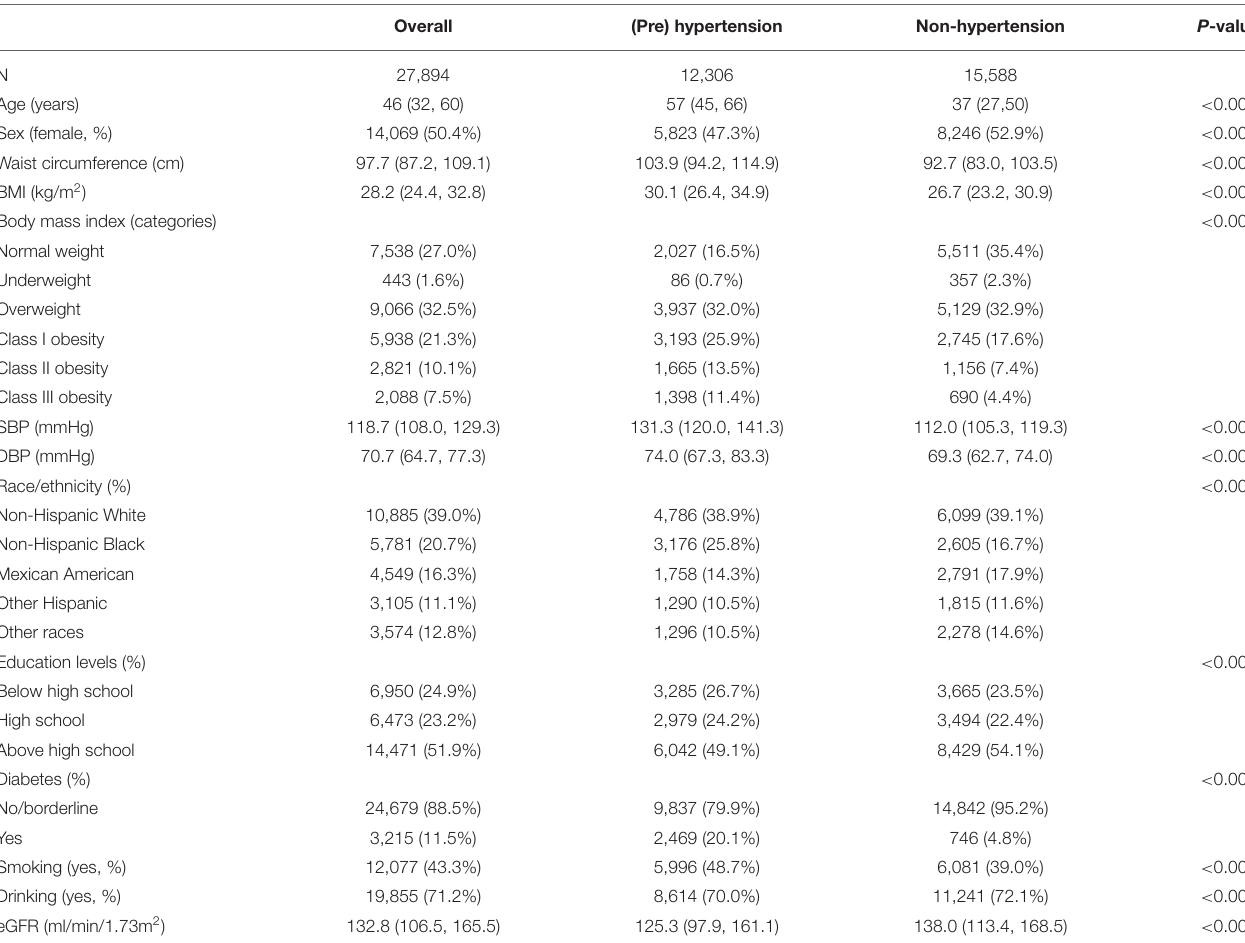
TABLE 1 | Characteristics of the study population. Overall (Pre) hypertension Non-hypertension P